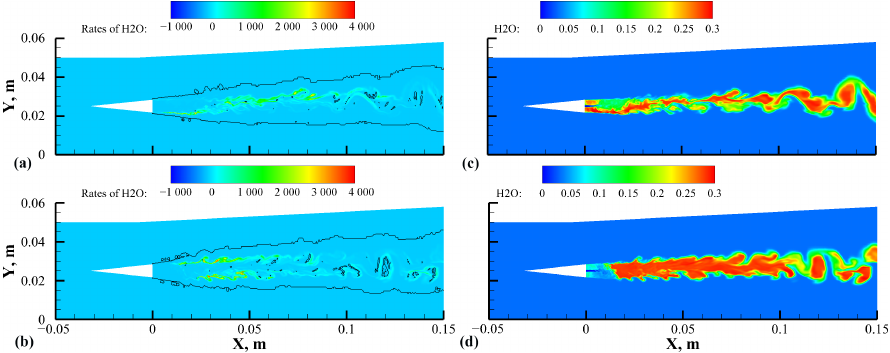
Figure 22. Contours of net production rates of water (isoline representing the 0 value) using the PaSR and PaSR-ISCM combustion models for ( a ) M0 and ( b ) M2; and mass fractions of water using these two combustion models for ( c ) M0 and ( d ) M2.